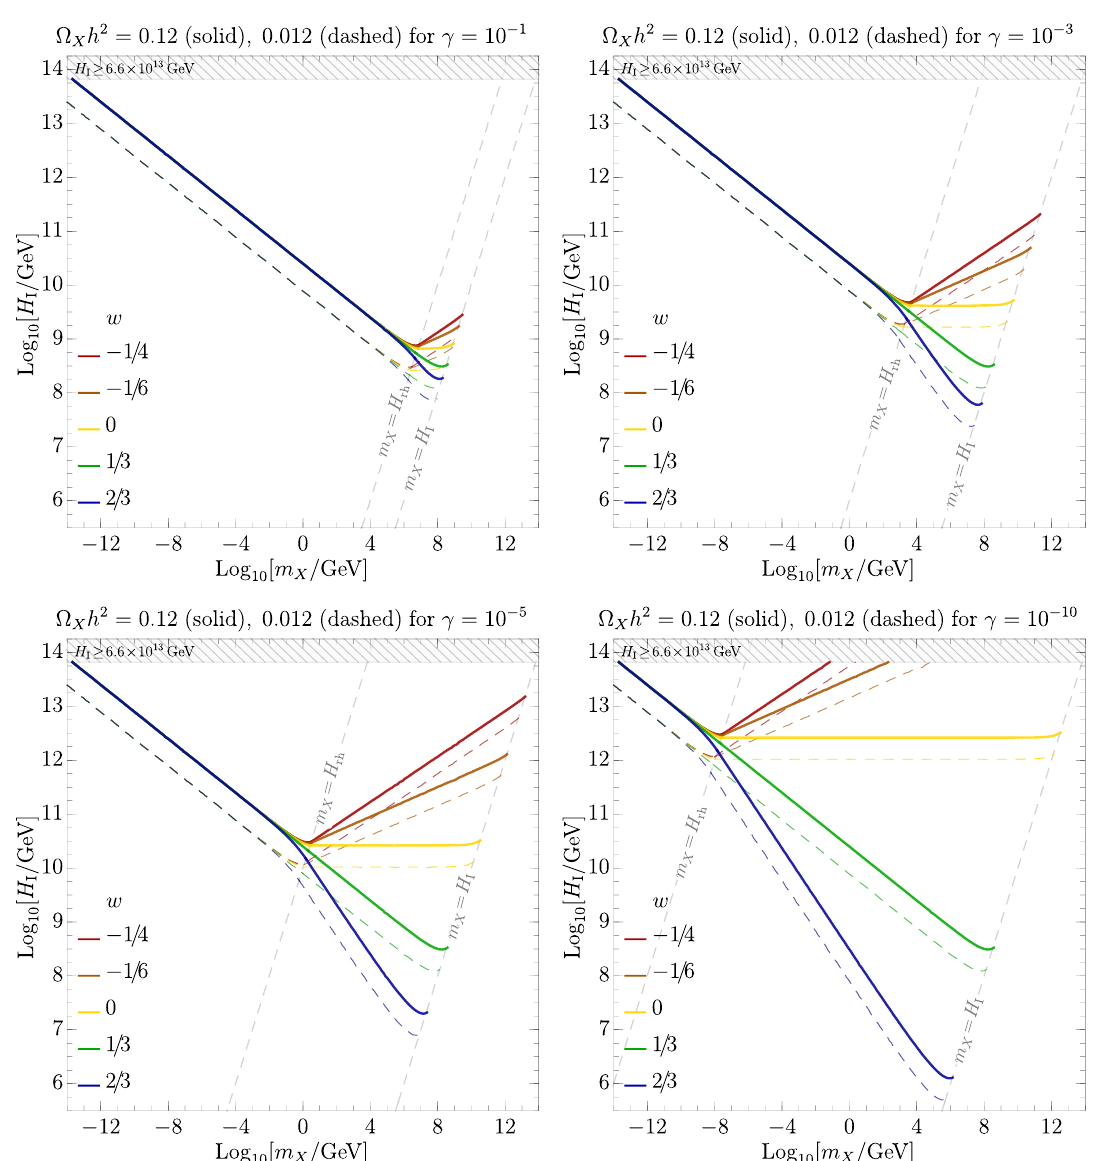
Figure 9 . Relations between the Hubble rate during in(cid:13)ation H I vs the vector DM mass m X that reproduces the observed relic abundance (cid:10) obs (solid curves) and 10% of the observed density X (dashed curves) for di(cid:11)erent values of the equation of state parameter w . Each panel corresponds to a di(cid:11)erent reheating e(cid:14)ciency (cid:13) = 10 (cid:0) 1 ; 10 (cid:0) 3 ; 10 (cid:0) 5 ; 10 (cid:0) 10 as indicated in the title of each plot. The hatched gray region is excluded by the Planck satellite at 95% C.L. [63].